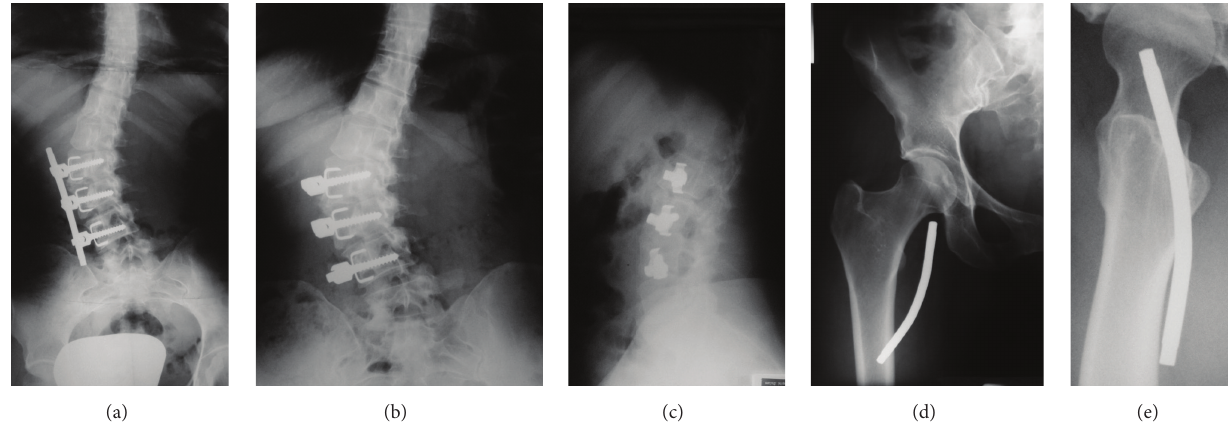
Figure 1: (a) Previous anterior view of lumbar spine. (b-c) Anterior and lateral views of lumbar spine, a three-level instrumentation without the anterior rod. (c-d) Anterior and lateral right hip views showing the rod migration.